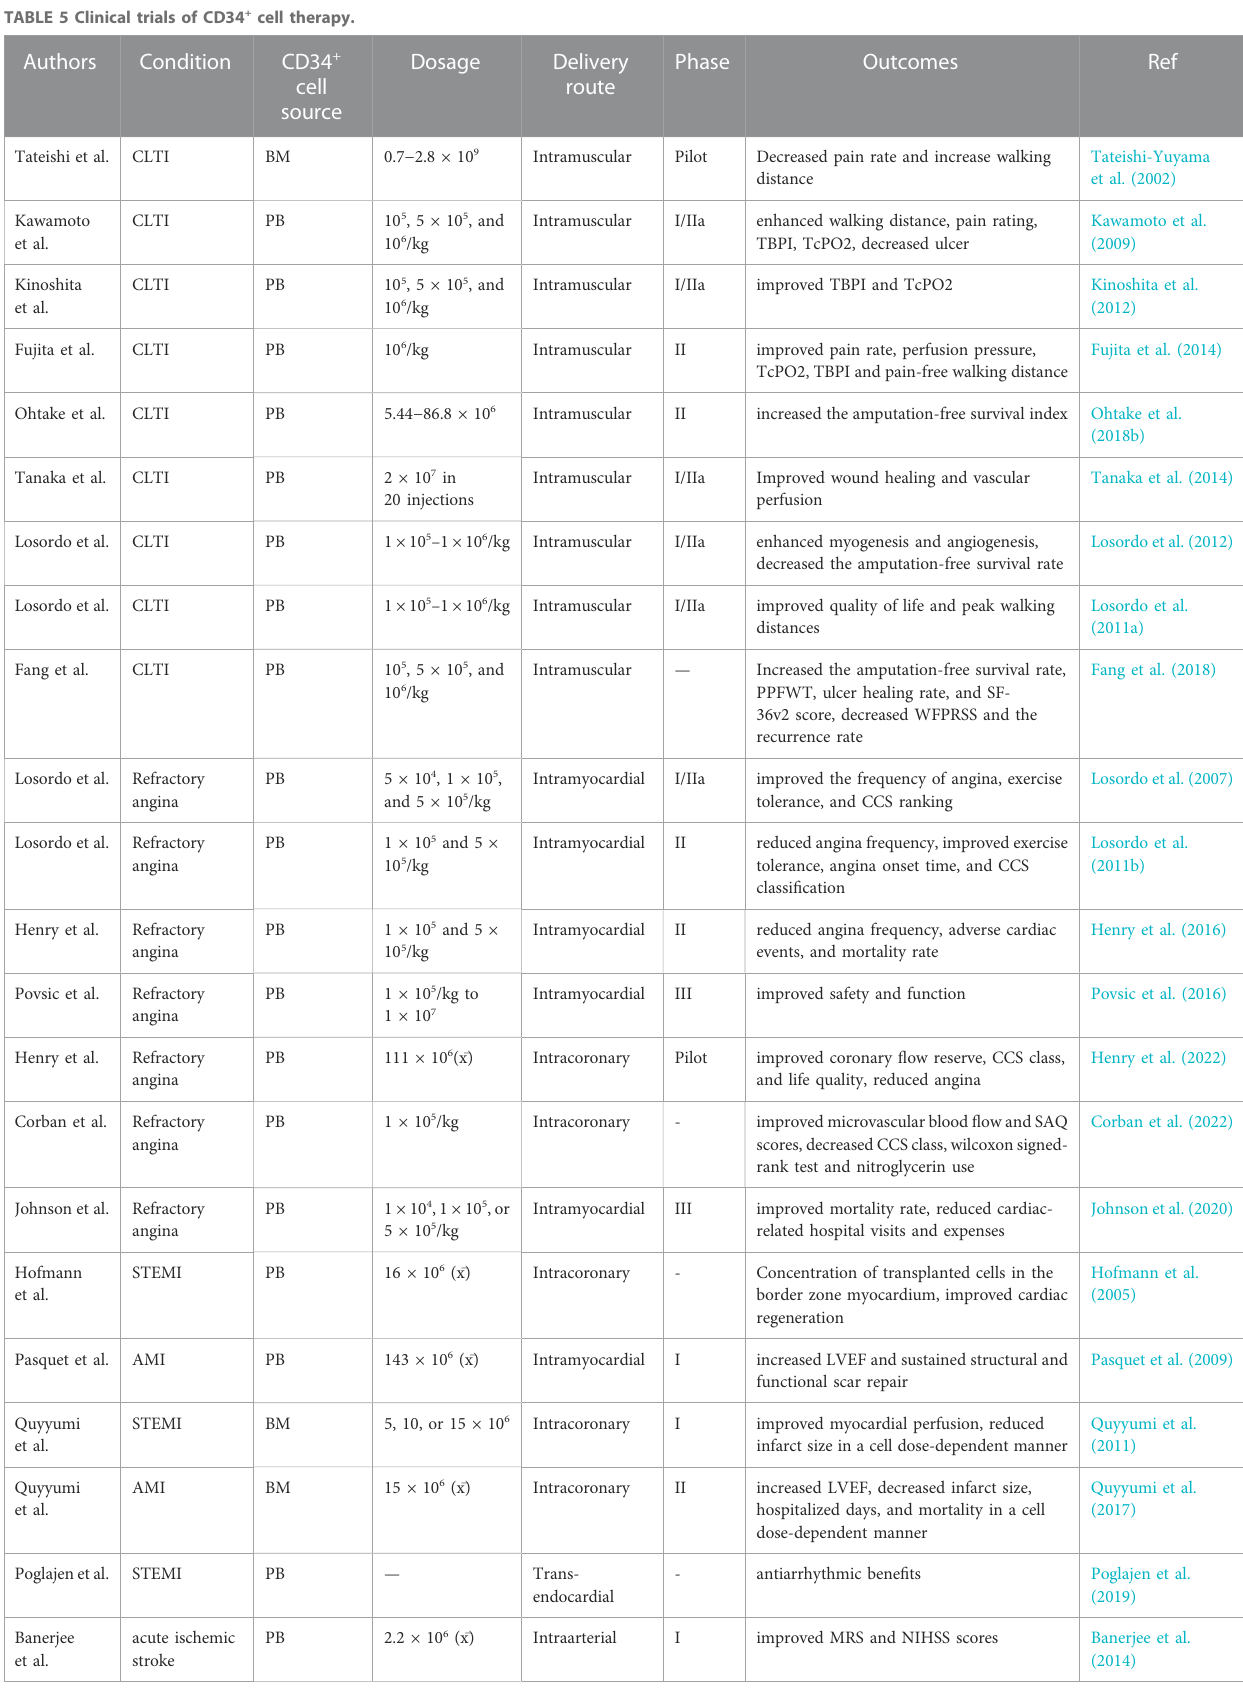
TABLE 5 Clinical trials of CD34 + cell